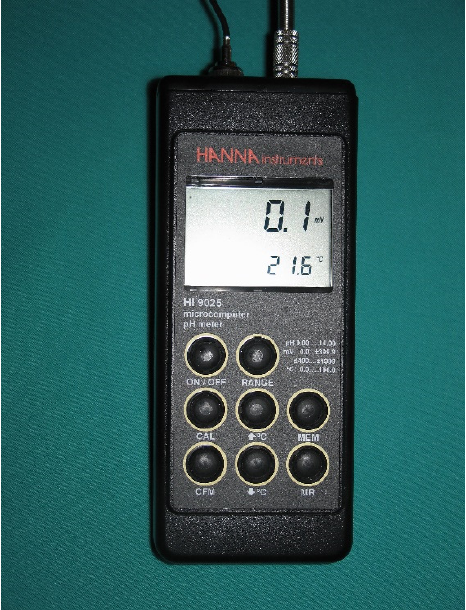
Figure 3. The Hanna waterproof instrument, a heavy-duty pH meter designed to provide accurate laboratory results.